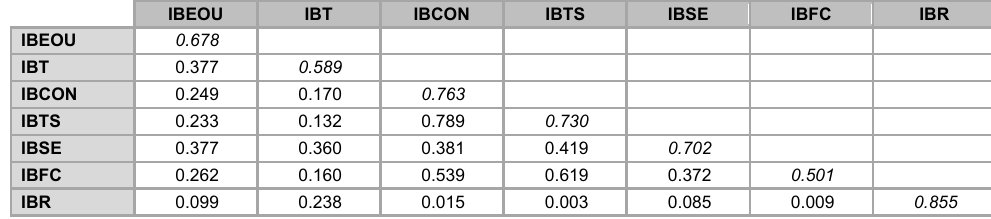
Comparison of average variance extracted and squared correlations in the low users’ measurement model